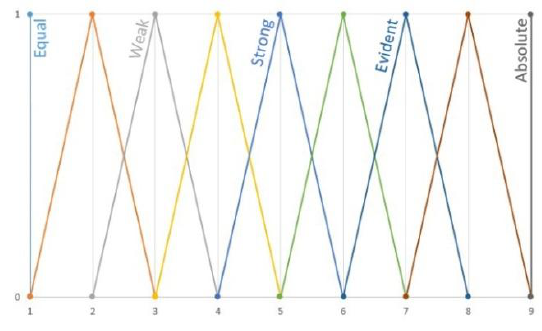
Figure 4. Triangular membership function term